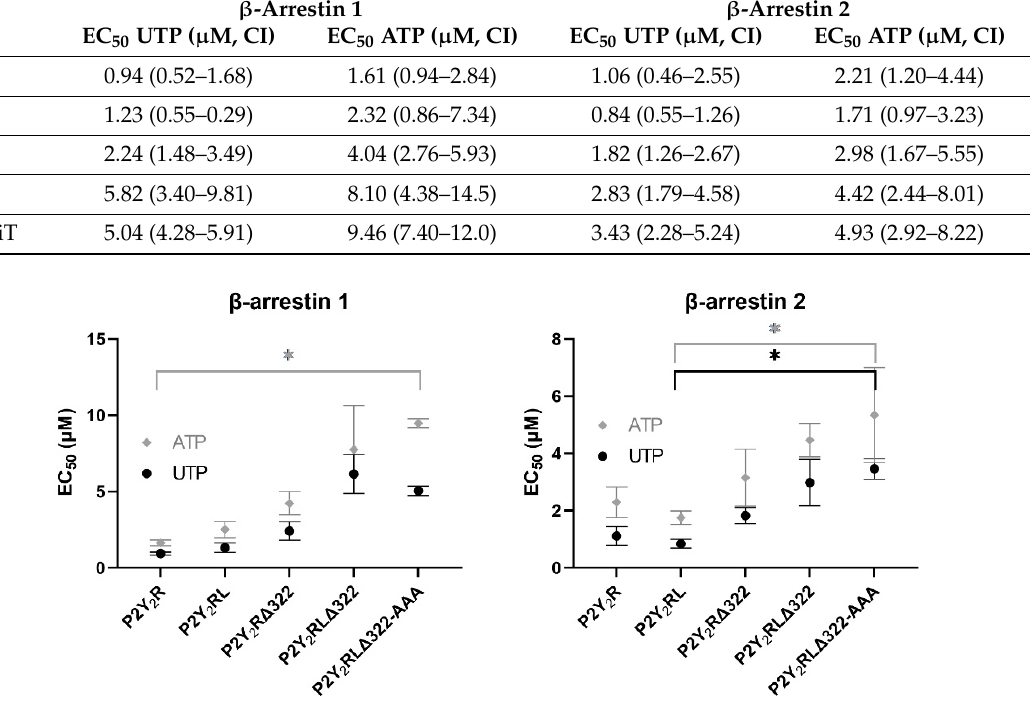
Figure 5. Visual representation of the obtained EC 50 values, as a measure of the potency of either UTP or ATP to induce the recruitment of β arr1 or β arr2 to the (modified) P2Y 2 R constructs in the NanoBiT ® system. Data are ± SEM (standard error of the mean) of three independent experiments, each performed in duplicate. * p < 0.05, as assessed in a Kruskal–Wallis analysis with post hoc Dunn’s.